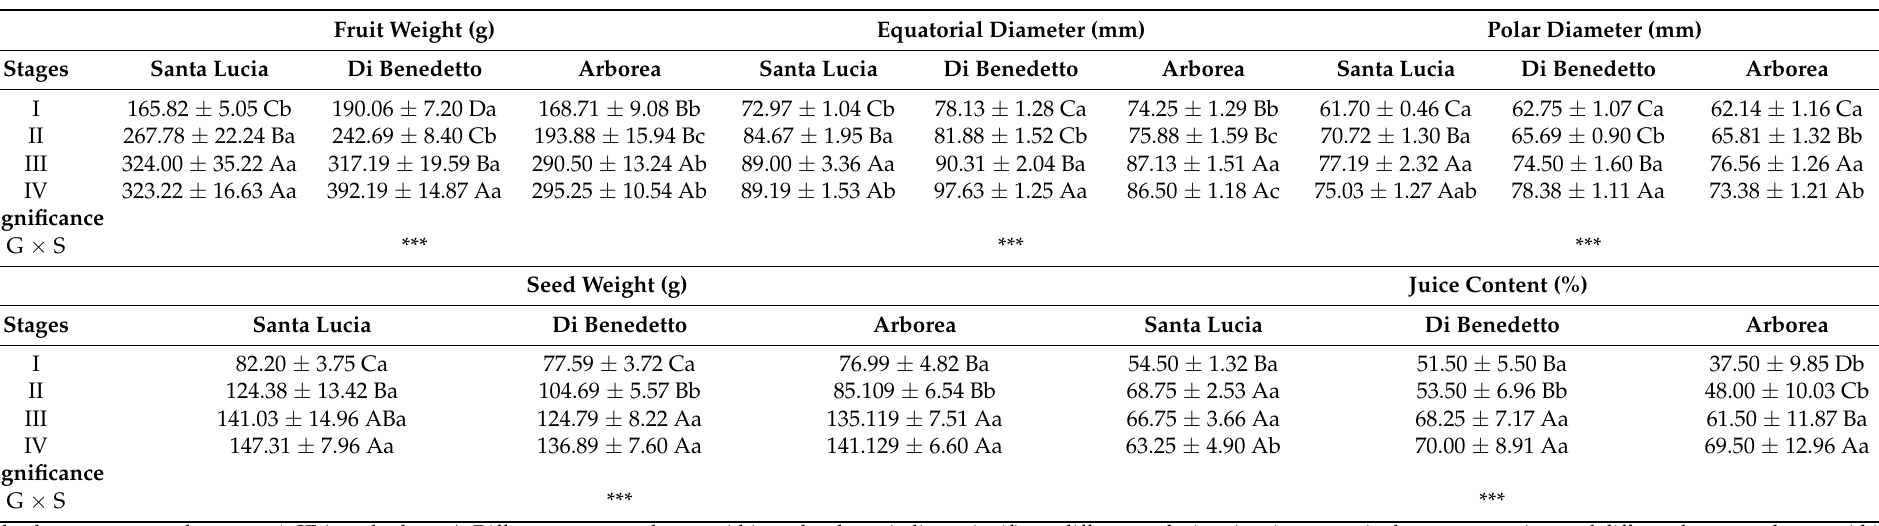
Table 2. Morphological parameters (fruit weight, equatorial diameter, polar diameter, seed weight, and juice content) of pomegranate fruits of the three genotypes (‘Santa Lucia’, ‘Di Benedetto’, and ‘Arborea’) at different ripening stages (I–II–III–IV). Fruit Weight (g)